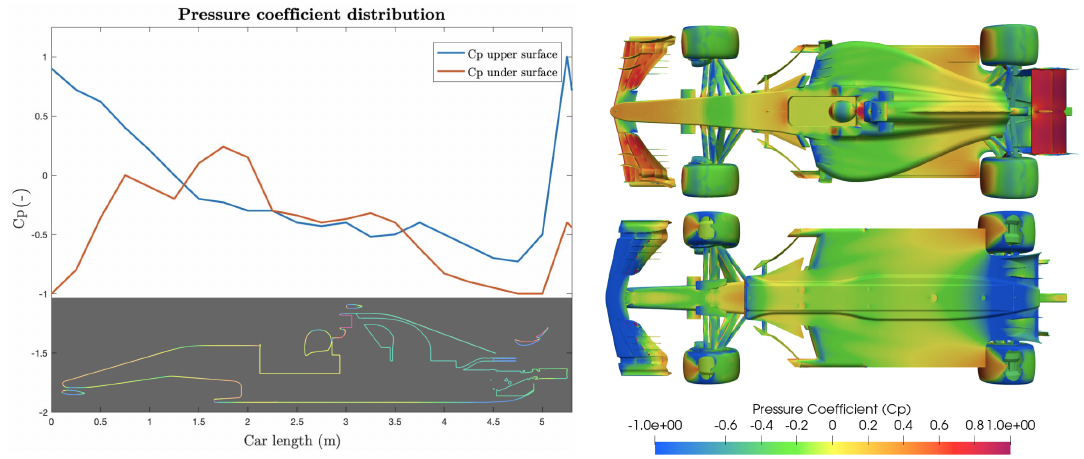
Figure 9. Pressure coefficient plot and representation on the upper and under surfaces of the